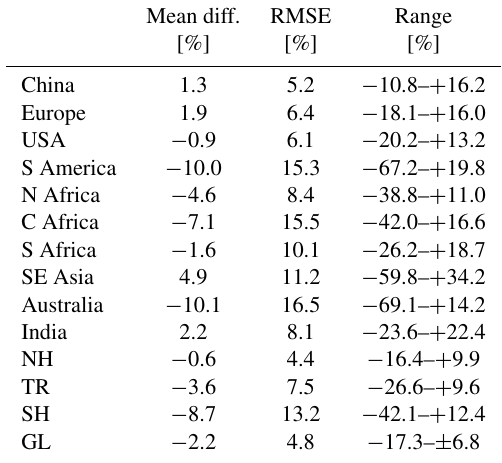
Table 5. Difference between the a posteriori emissions from the multiple-species assimilation and NO 2 -only assimilation. Relative difference for the regional 10-year mean emissions (left column), RMSE for the monthly regional emissions (central column), and range of relative difference for the monthly regional emissions (right column) are